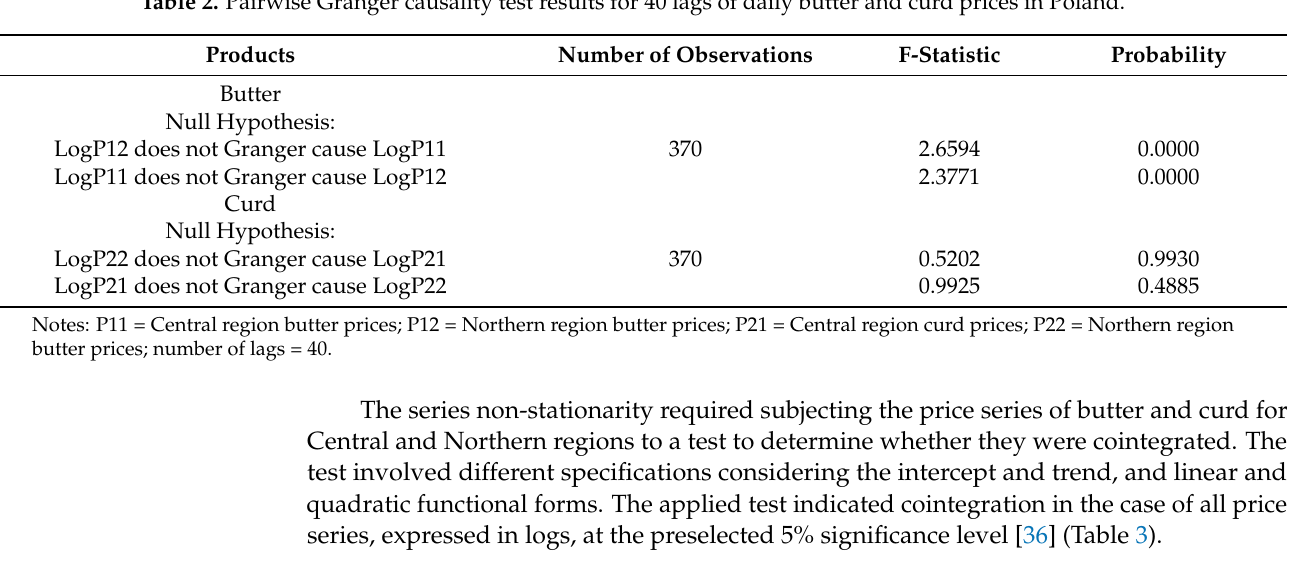
Table 3. Engle–Granger cointegration test for butter and curd prices in Poland.